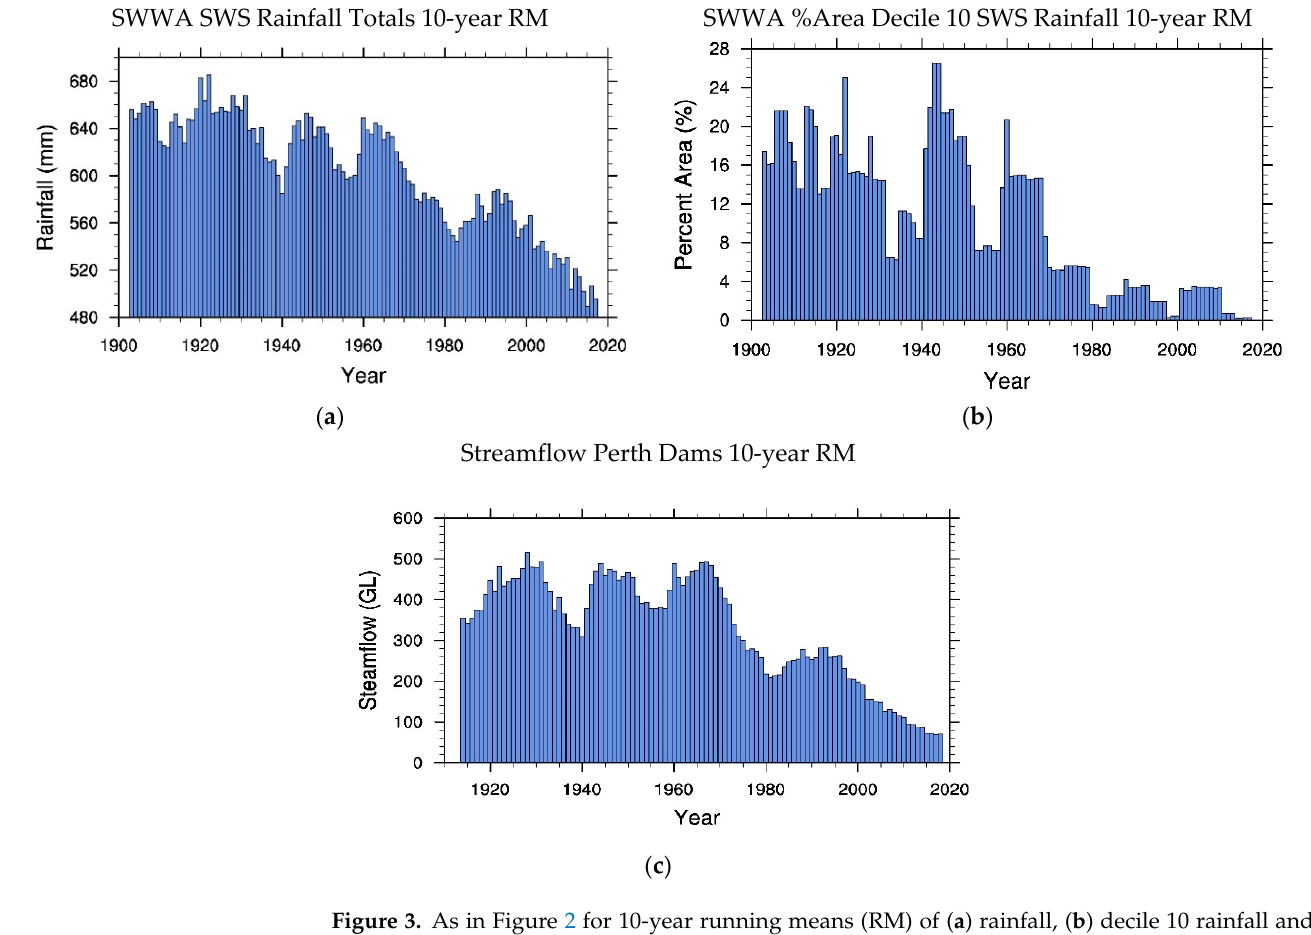
Table 3. The average gradients or trends of 10-year RM of SWWA rainfall in SWS, January to